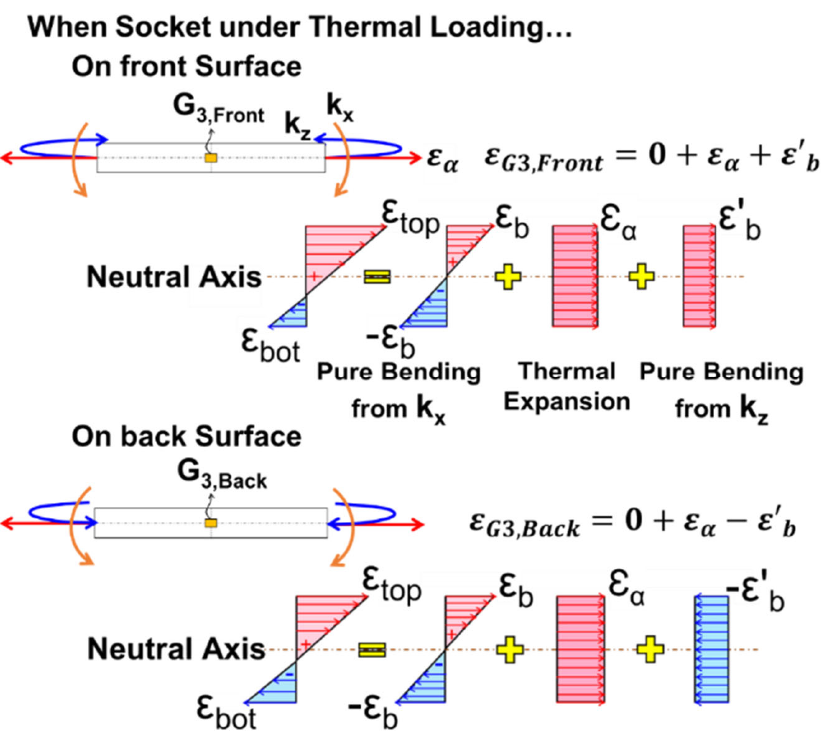
Figure 2. Strain distributions across the thickness of the DIMM socket under thermal loading.